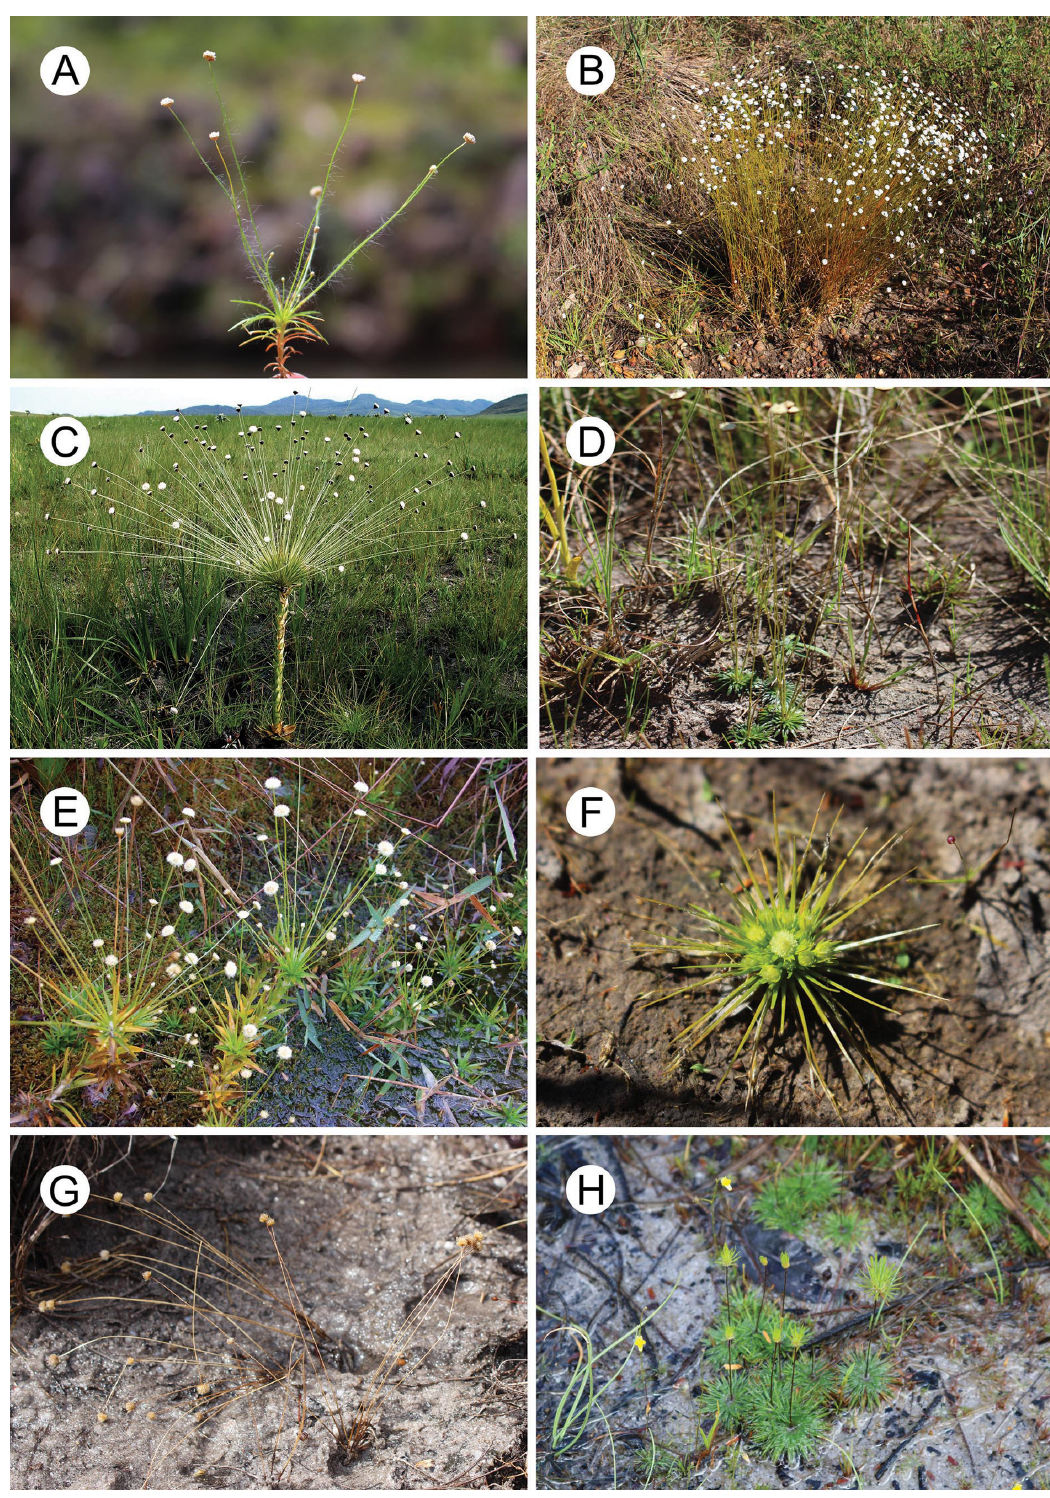
Fig. 9. Species of Paepalanthoideae (Eriocaulaceae) from the Chapada dos Veadeiros National Park. A . Paepalanthus subtilis Miq . B . P. trichophyllus (Bong.) Körn. . C . P. urbanianus Ruhland . D . Syngonanthus cabralensis Silveira . E . S. caulescens (Poir.) Ruhland . F . S. cuyabensis (Bong.) Giul., Hensold & L.R.Parra. G . S. davidsei Huft . H . S. decorus Moldenke